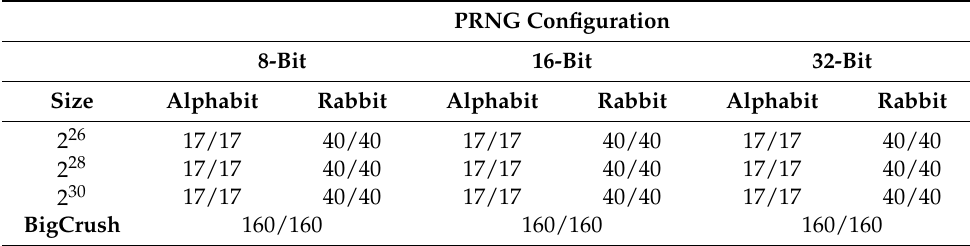
Table 4. Results of pseudorandomness tests using TestU01 suite.